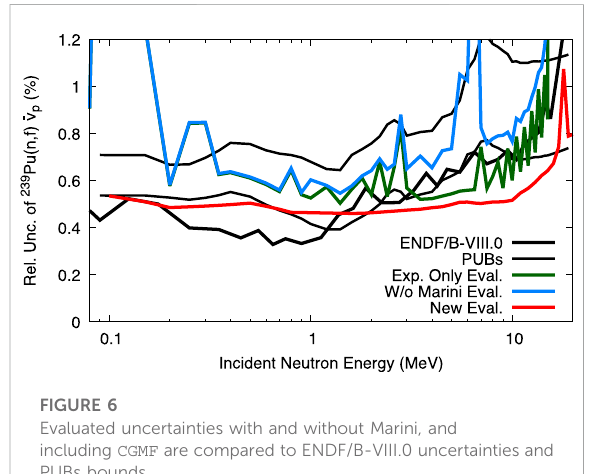
FIGURE 6 Evaluated uncertainties with and without Marini, and including CGMF are compared to ENDF/B-VIII.0 uncertainties and PUBs bounds.